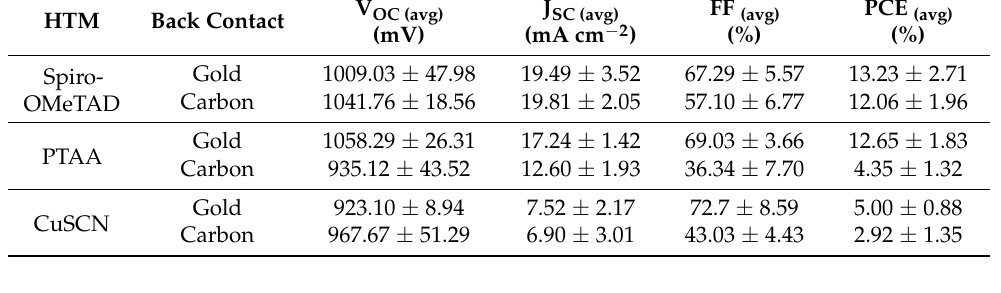
Table 4. The average and standard deviations of PV parameters of the carbon-based devices with different HTMs and the densification material, including Spiro-OMeTAD, PTAA, and CuSCN. HTM